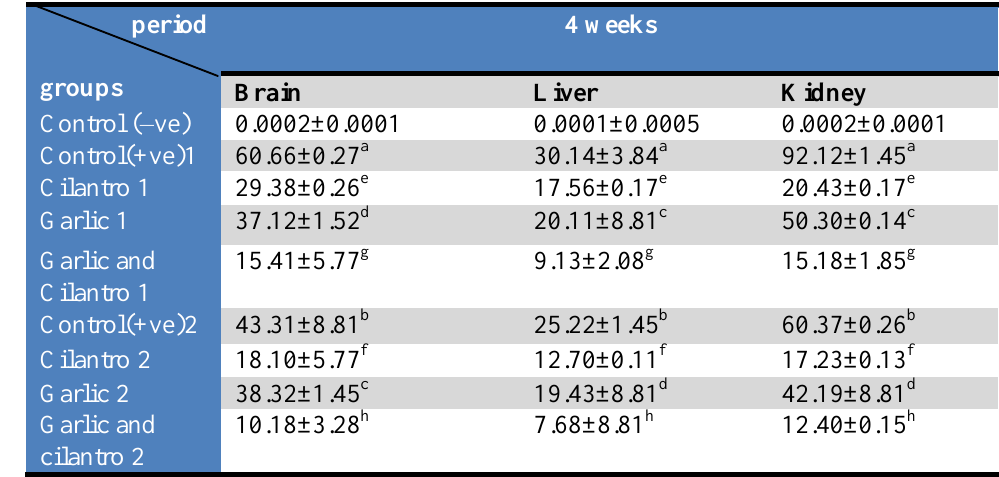
Table (1): Residual of mercuric chloride in rats organs which treated orally with extracts of cilantro (50mg/kg.BW) and garlic (100 mg /kg.BW) for (4 weeks).